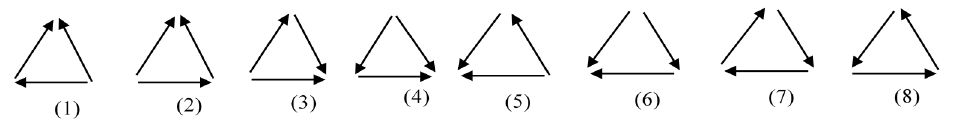
Figure 5. Structures in the sustainable vector model. Reproduced with permission from Colceag F.